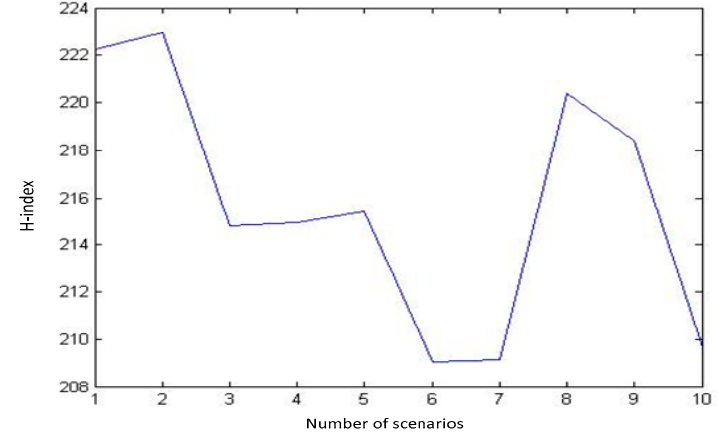
Figure 2. Ten randomly generated scenarios and their related H-indexes.